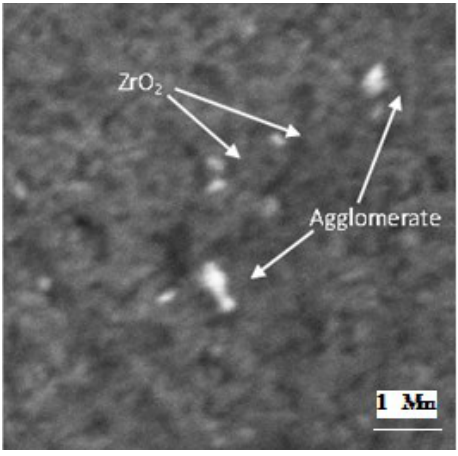
Figure 15. SEM for A356 Alloy containing ZrO 2 agglomerated particles.